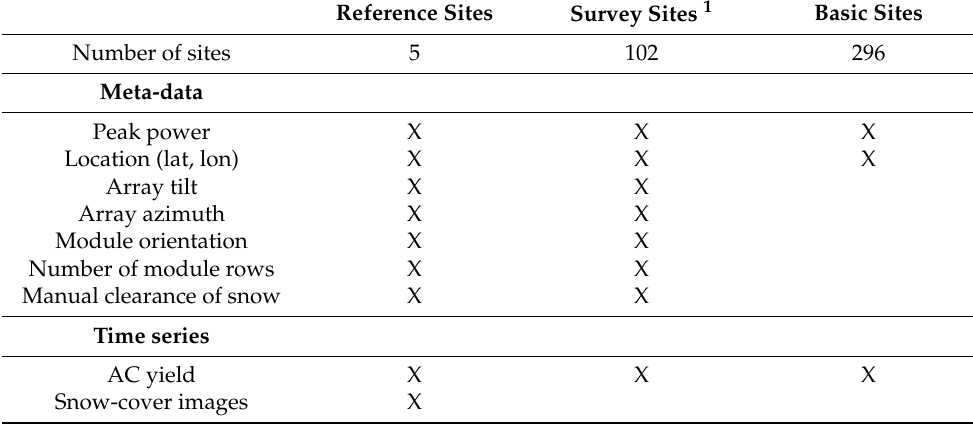
Table 2. Overview of sites included in the study and the data collected or available. Reference Sites Survey Sites 1 Basic Sites Number of sites 5 102